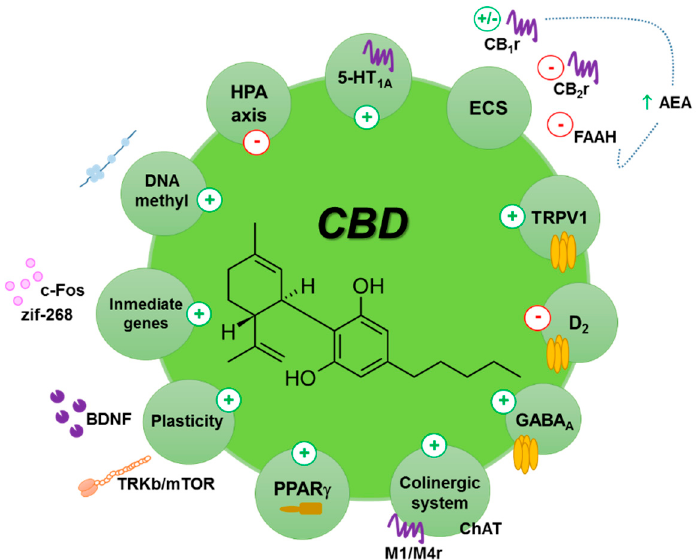
Figure 1. Schematic representation of the main hypothesized mechanisms described for the anxiolytic, antidepressant and antipsychotic actions of CBD. AEA: anandamide; 5-HT 1A : serotonin receptor 1A; BDNF: brain delivered neurotrophic factor; CB 1 r: cannabinoid CB1 receptor; CB 2 r: cannabinoid CB2 receptor; ChAT: choline acetyltransferase; D2: dopamine receptor D2; DNA methyl: DNA methylation; ECS: endocannabinoid system; FAAH: fatty acid amide hydrolase; HPA axis: hypothalamus pituitary-axis; M1 / M4r: muscarinic receptor 1 and 4; PPAR γ : peroxisome proliferator activated receptor gamma; TRKb / mTOR: tropomyosin-receptor-kinase B / mammalian target of rapamycin; TRPV1: transient receptor potential cation channel subfamily V member 1.